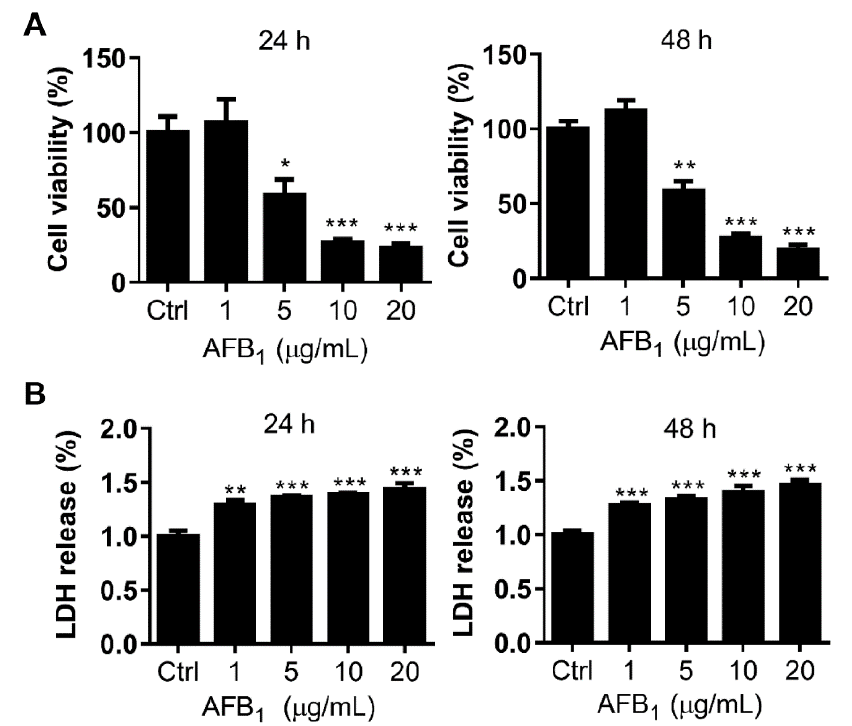
Figure 2. AFB 1 exhibits significant cytotoxicity toward IMR-32 cells. ( A ) The IC50 values of AFB 1 were 6.18 µ g / mL and 5.87 µ g / mL in IMR-32 cells after 24 h and 48 h of treatment, respectively. ( B ) Relative LDH release by IMR-32 cells exposed to di ff erent concentrations of AFB 1 for 24 h and 48 h. All experiments were repeated three times and the values represent the mean ± SD of three independent experiments. Statistical significance was defined as * p < 0.05, ** p < 0.01, or *** p <